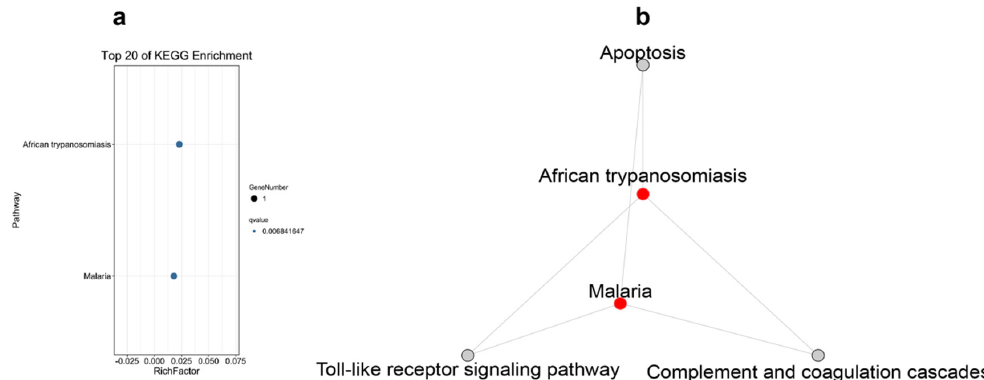
Figure 9. The Top 20 KEGG Pathways Enriched by the Differentially Expressed Genes of the Shared Genes Between the Liver and Spleen at 48 h Postinjection, and the Network Graph among these Pathways: ( a ) the Pathway Enrichment of the Shared Differentially Expressed Genes; ( b ) the Network Graph among these